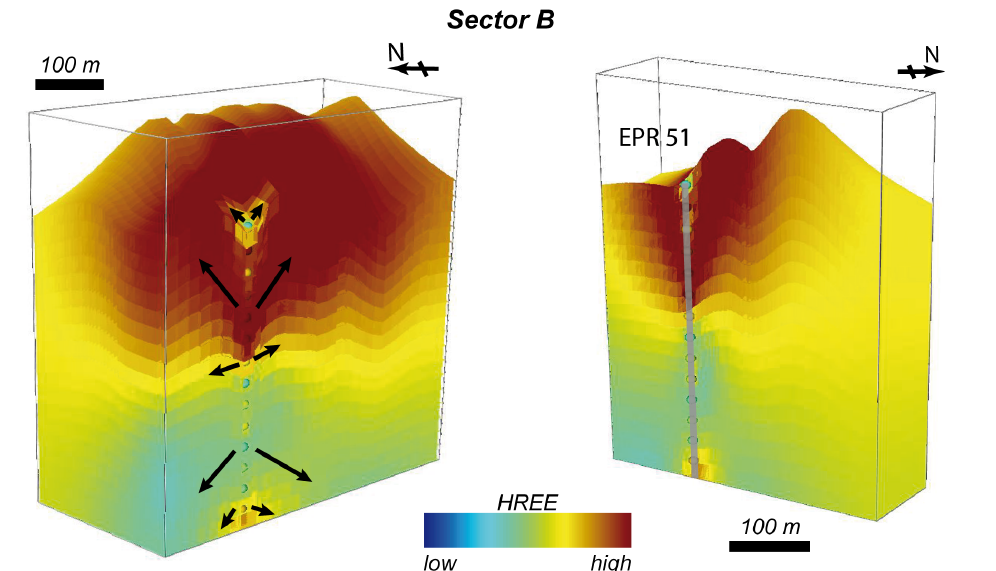
Figure 7. Schematic cross-section through the SGrid of Sector B with interpolated HREE contents of drillhole EPR51 (different colored spheres). Black arrows indicate the extrapolation trend of the Discrete Smooth Interpolation (DSI)